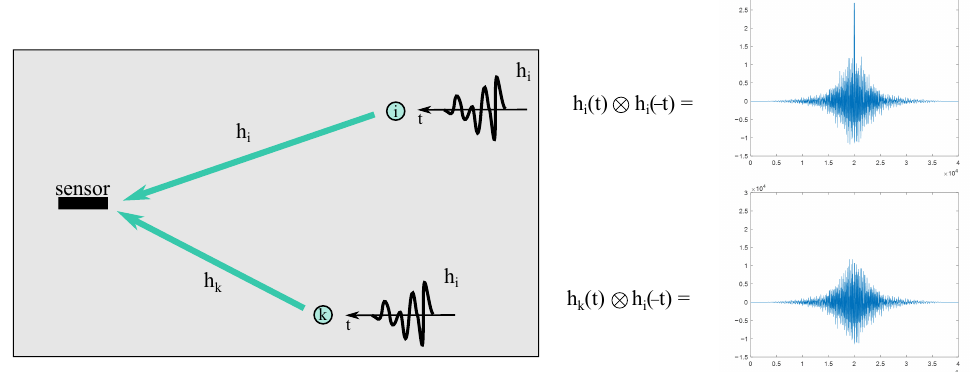
Figure 9. Time reverse selectivity.